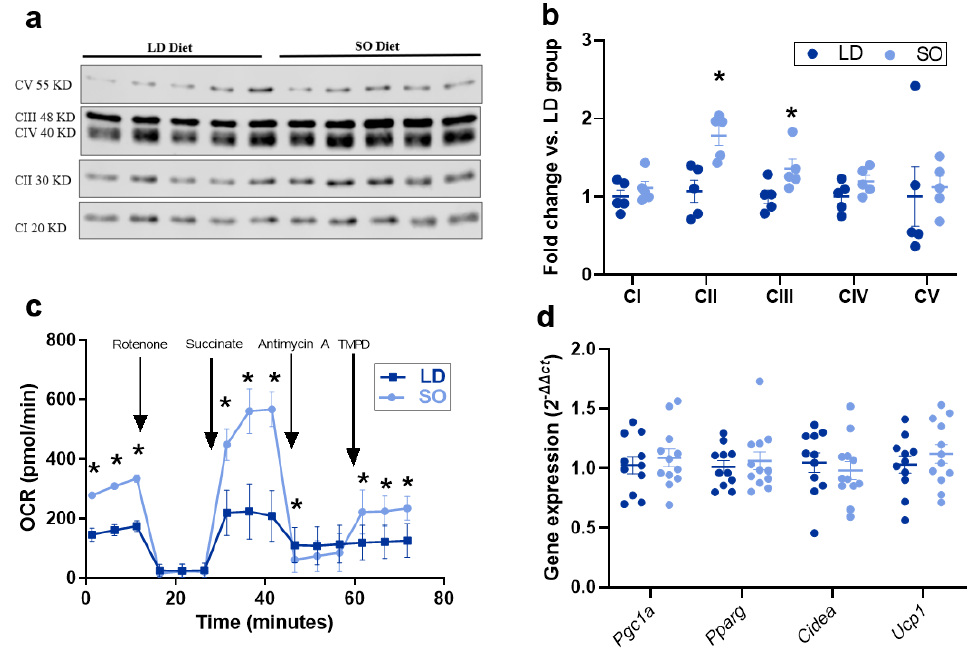
Figure 4. Effect of LD and SO diets on mitochondrial function in BAT. ( a ) Western blot of respiratory complexes from mitochondrial BAT extracts; CI: Complex I, NADH-coenzyme Q oxidoreductase; CII: Complex II, Succinate-Q oxidoreductase; CIII: Complex III, Q-cytochrome-C oxidoreductase; CIV: Complex IV, Cytochrome C oxidase; CV: Complex V; ATP synthase (N = 5/group). ( b ) Quantification of average respiratory complex fold change for each protein abundance, standardized to total protein as a loading control, found in Figure S1, in the SO diet compared to the LD diet (N = 5/group). ( c ) Electron flow assay to measure uncoupled respiration in BAT mitochondrial extracts expressed as an average for individual timepoints over a 72-min period. ( d ) Gene expression for Pgc1a , Pparg , Cidea , and Ucp1 , expressed as relative to the LD group (N = 11–12/group). ( b , d ) Data expressed as the average ± SEM (-c) data expressed as the average of two independent experiments with two mitochondria samples each, ± SD. Differences between LD and SO diet groups were assessed by a two-sample t -test, where an asterisk (*) indicates p < 0.05.